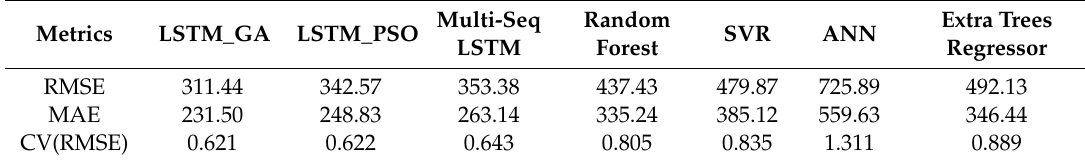
Table 4. Evaluation results of the benchmarks and the GA and PSO models.